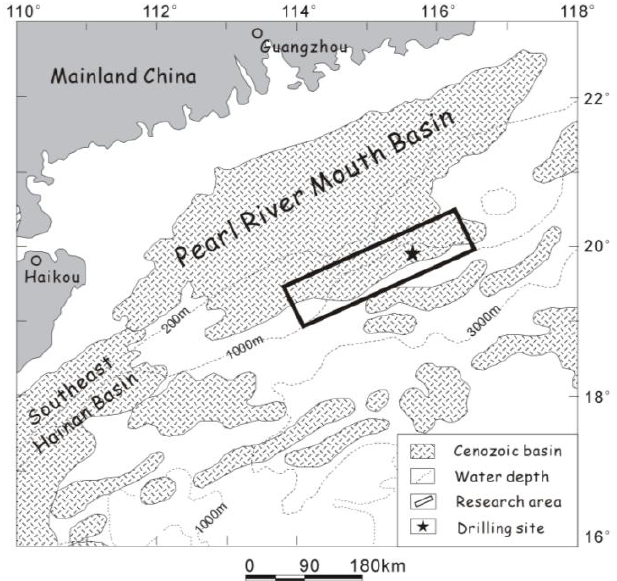
Figure 3. The location of the Shenhu area in the north continental slope of the South China Sea. The square region surrounded by black solid lines is the research zone in this